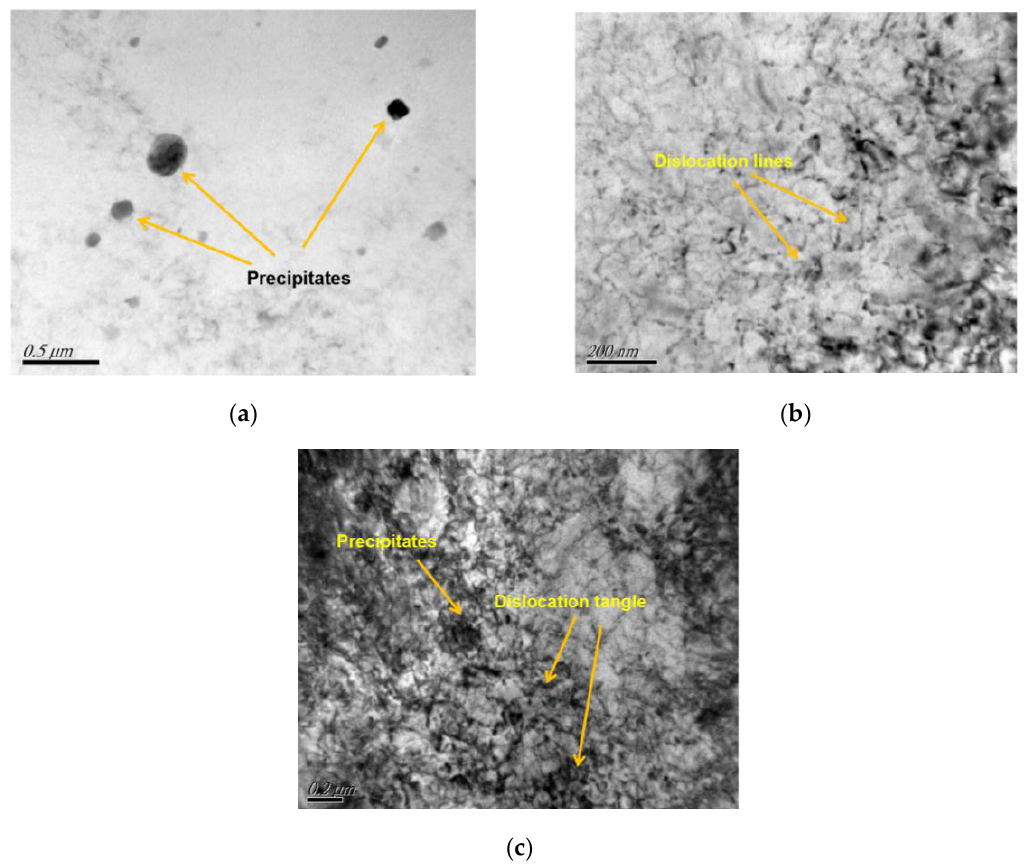
Figure 8. TEM images of the specimen at different temperatures for ( a ) before LP; ( b ) LP at 25 °C; ( c ) WLP at 130 °C.